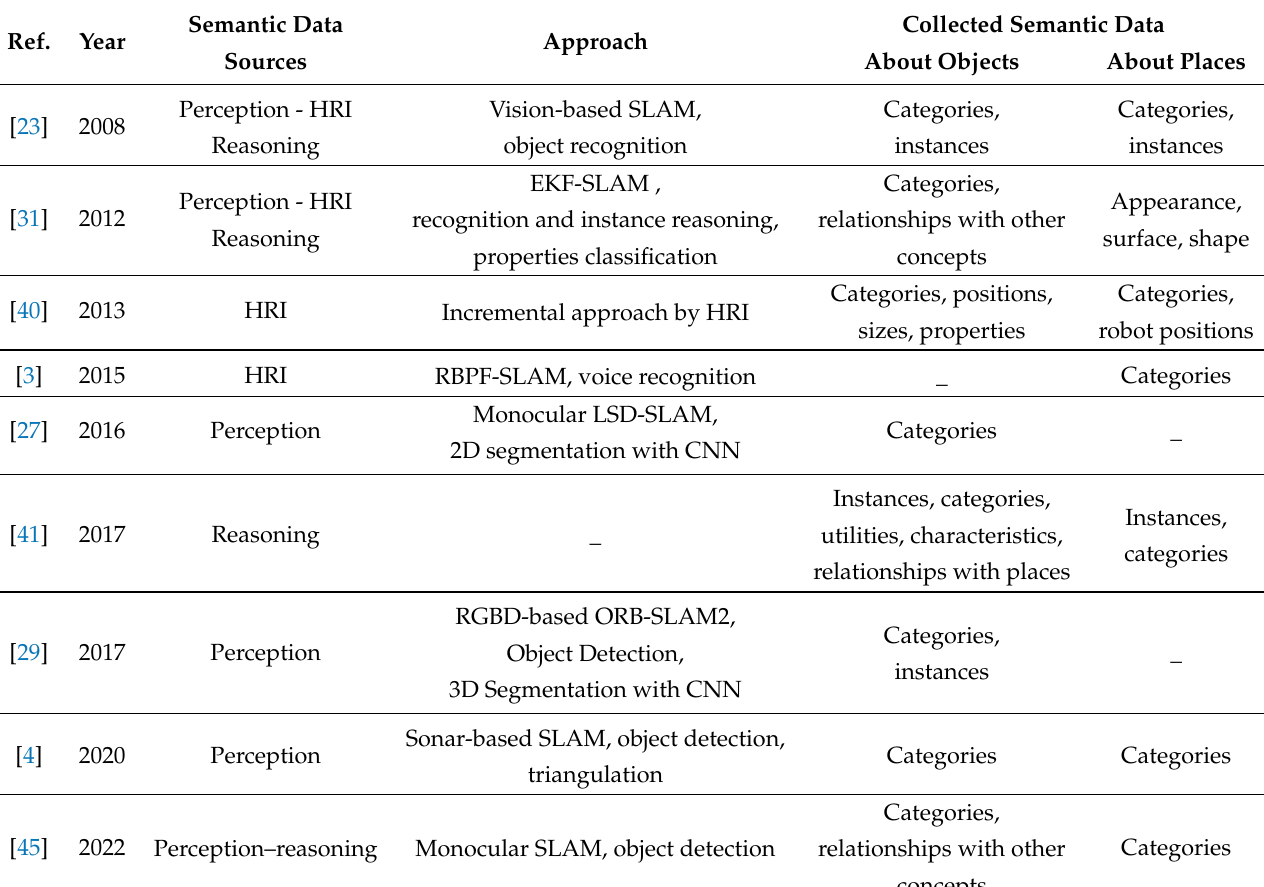
Table 1. Summary of the reviewd works in relation to the single-robot semantic-mapping framework.